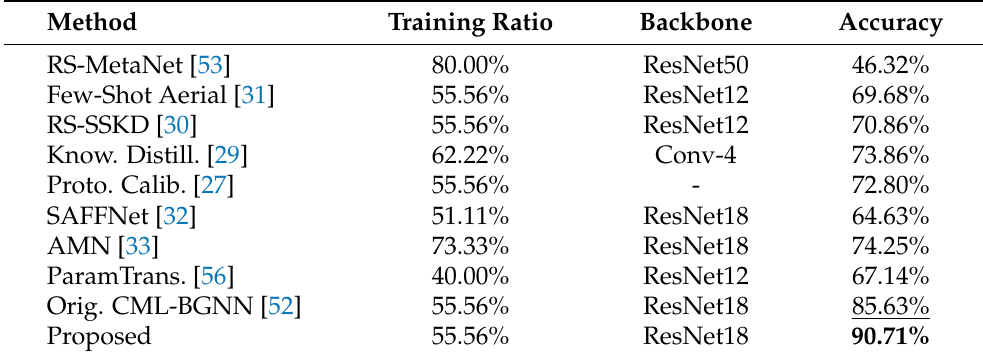
Table 5. Classification accuracies on